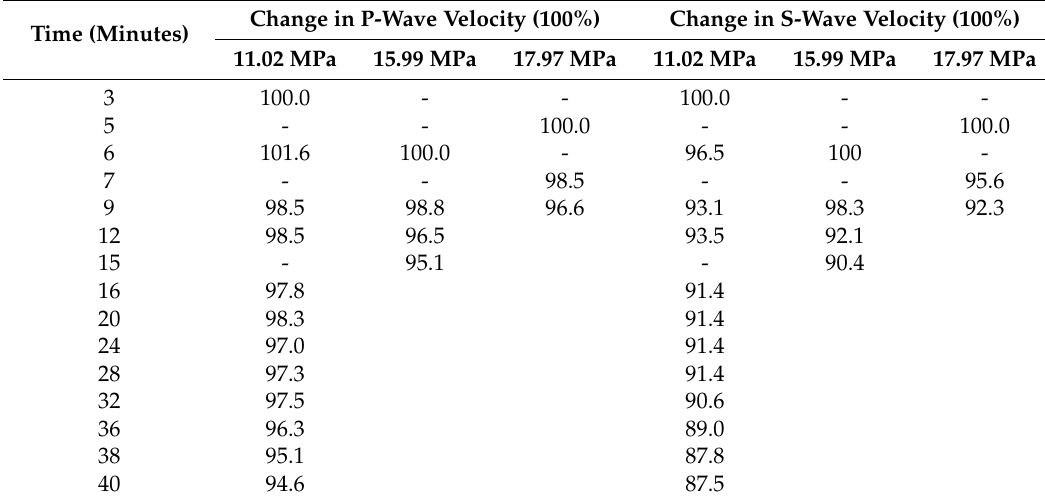
Table 2. Ultrasonic velocity data acquired during the short-term creep process.